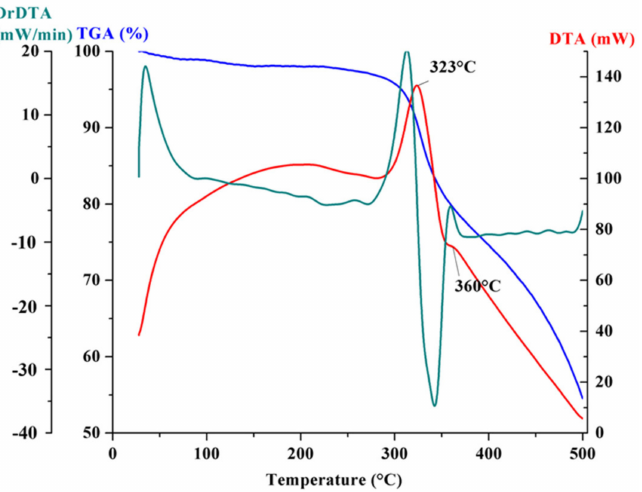
Figure 6. TGA/DTA analysis for the PAN/DCPD microvascular